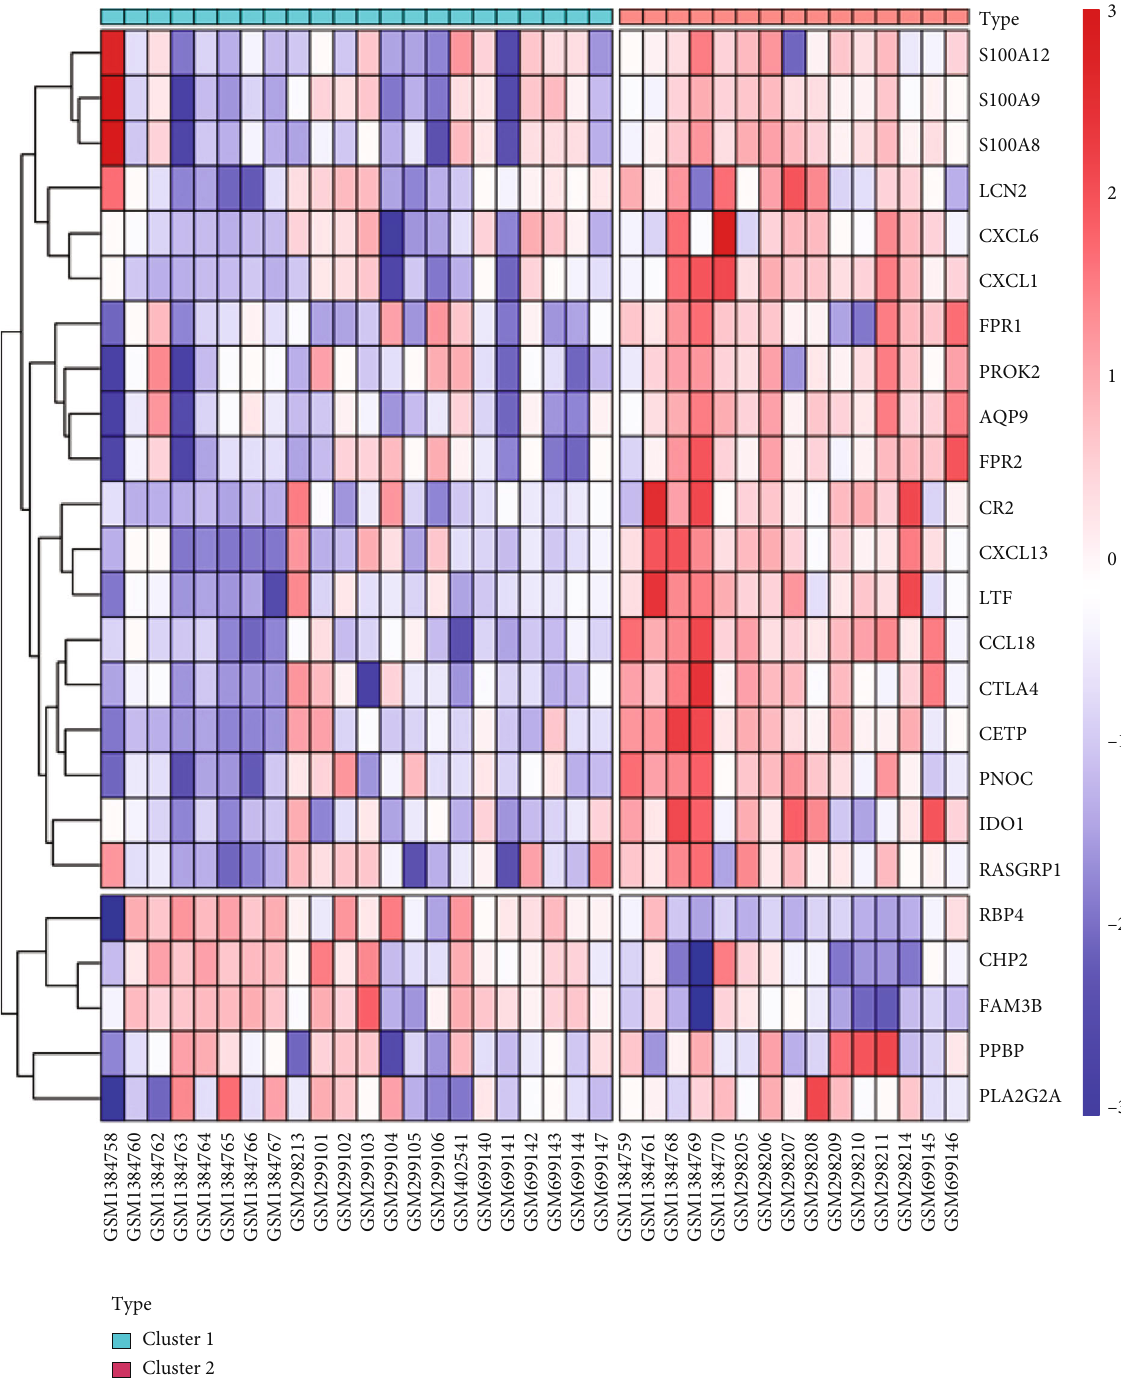
Figure 6: Development of immune subtypes based on immune-related IC-DEGs. (a) The consensus score matrix of IC samples when k = 2 . (b) Consensus CDF curve when k = 2 – 7 . (c) Relative alterations in the area under CDF curve. (d) PCA plots perform that all IC samples are categorized as two immune subtypes. (e, f) The optimal number of clusters determined by Nbclust. (g) Abundance of 28 in fi ltrated immune cells evaluated by ssGSEA for cluster1 and cluster2. (h) The heatmap performs the expression of immune-related IC-DEGs in IC immune